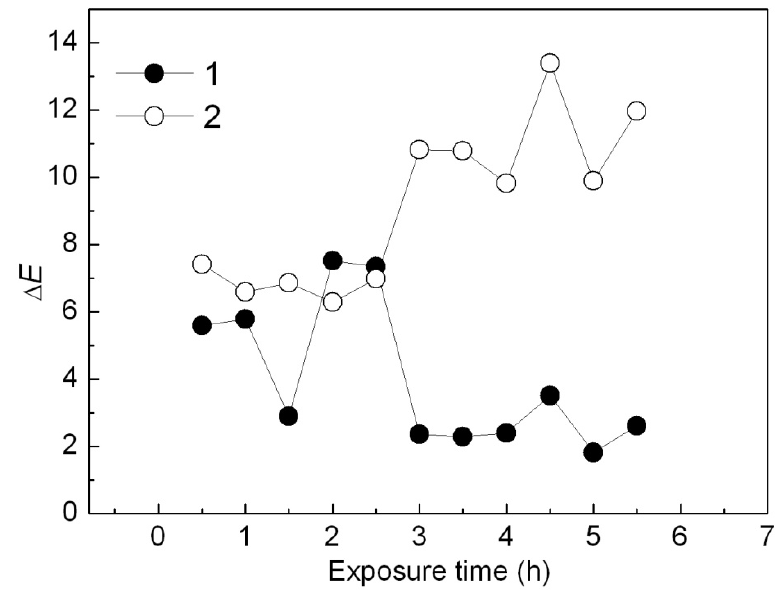
Figure 15. Effect of UV irradiation time on Δ E of PP samples colored with the